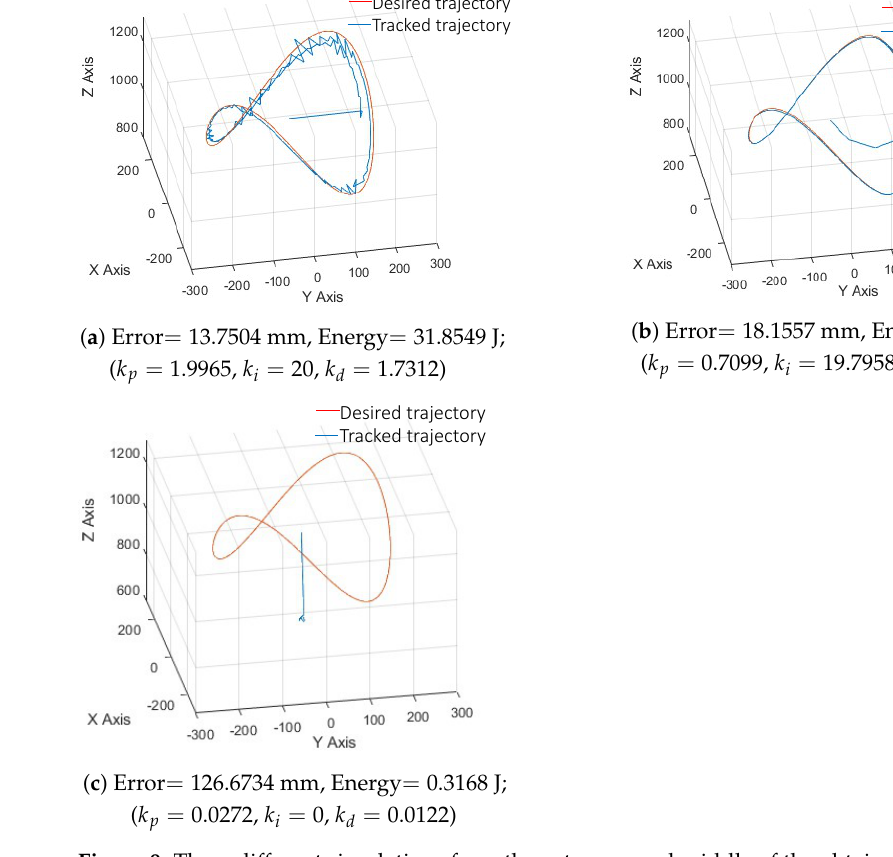
Figure 9. Three different simulations from the extremes and middle of the obtained Pareto front of Figure 7 and associated PID gains. ( a ) Low error but high energy consumption; ( b ) an error–energy balance; ( c ) denotes low energy but high error. Table 4. Averages of performance metrics over the multi-objective results. Best values in bold.